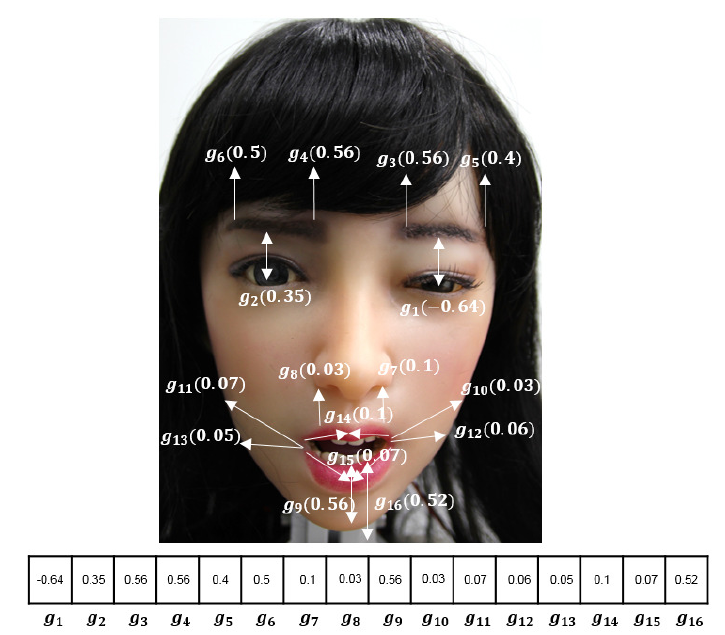
Figure 4. Facial expression of the EveR android generated by randomly generated genes.